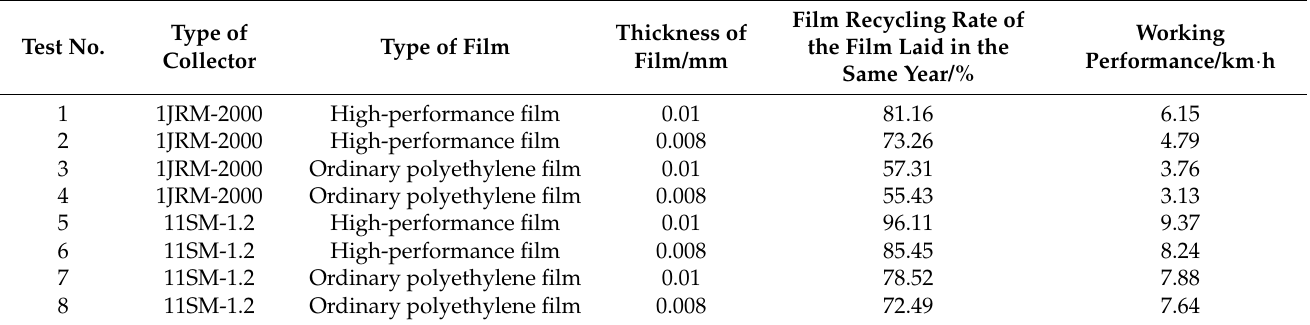
Table 6. Results of field test on curl-up collecting of